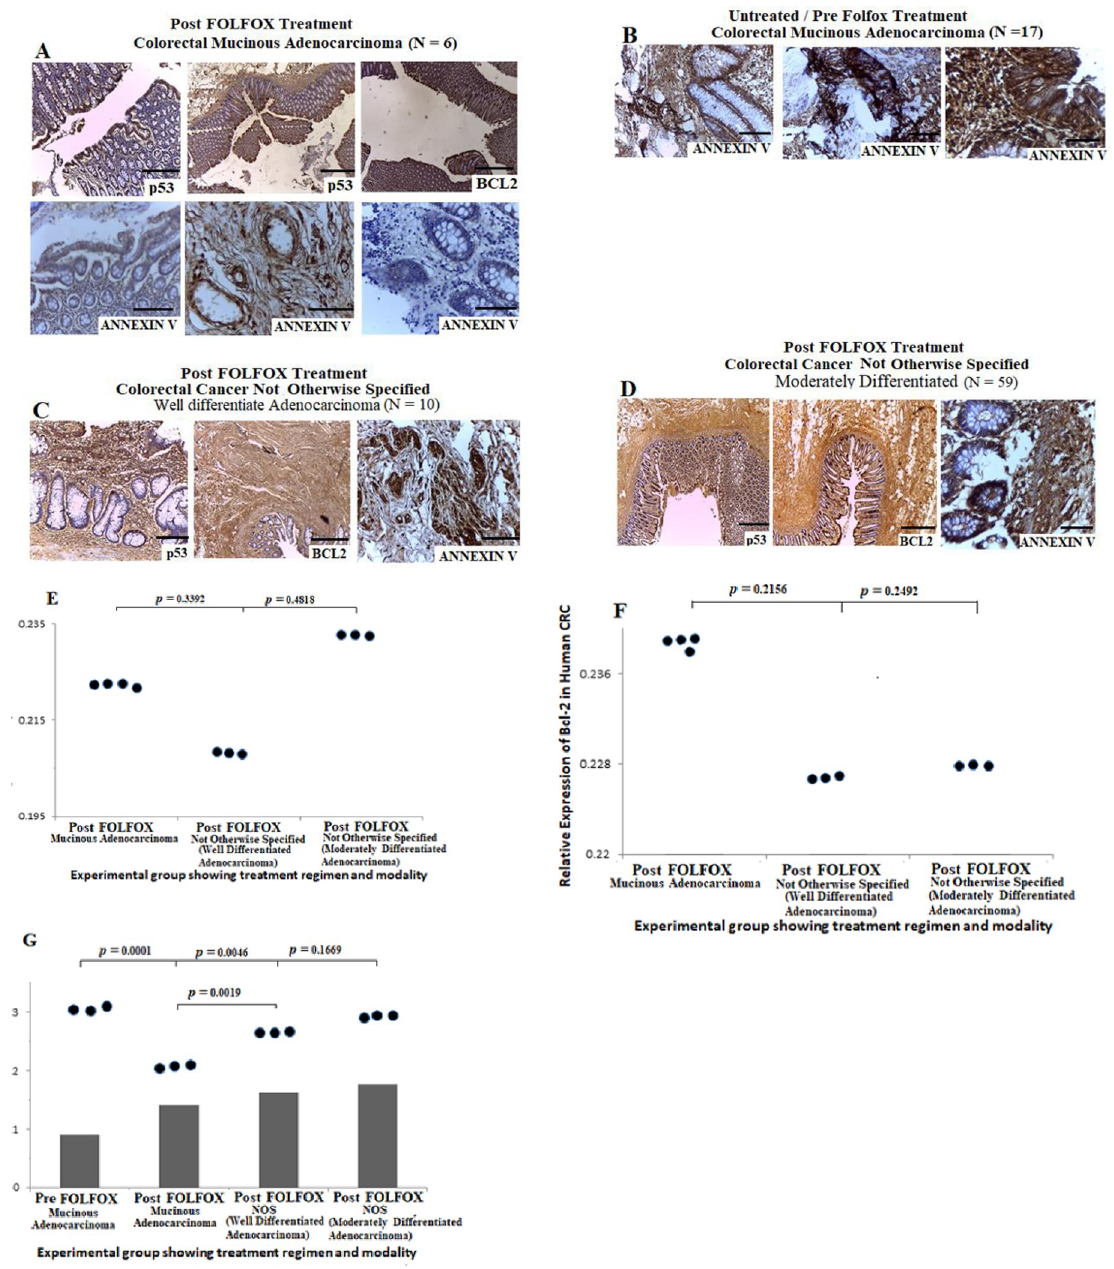
Fig 6. Prognostic significance of p53, Bcl-2 and Annexin V in human colorectal cancer cells pre and post-treatment with FOLFOX n (scale bar = 50 μ m for H&E and scale bar = 100 μ m for IHC). A) Colorectal mucinous adenocarcinoma sections showing positive expression of p53, Bcl-2 and Annexin V post-treatment with neoadjuvant FOLOFOX chemotherapy regimen, Scale bar, 20 um. B) Colorectal mucinous adenocarcinoma lesions showing increase in expression of Annexin V pre-FOLFOX treatment. C—D) Sections from colorectal cancer not otherwise specified (well differentiated and moderately differentiated types) post-FOLFOX chemotherapy showing strong positive expressions of p53, Bcl-2 and Annexin V. E-G) Quantitative analysis of p53, Bcl-2 and Annexin V showing the expression pattern typified in dot plot pre and post-treatment with